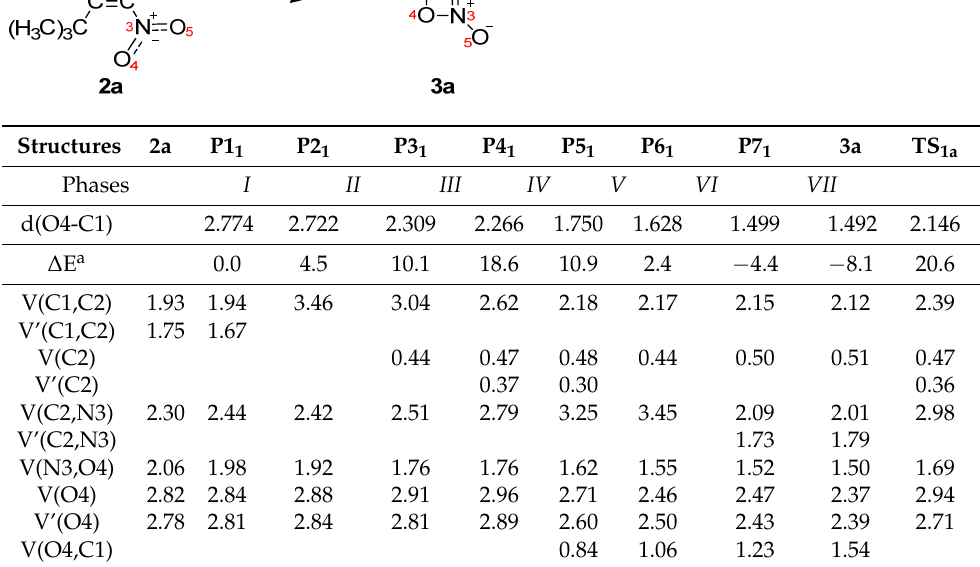
Figure 4. Attractor positions of the most important ELF valence basins of the IRC structures P1 1 – 3a together with simpli- fied representation of the molecular mechanism by Lewis-like structures arising from the topological analysis of the ELF along the reaction path for the formation of 4,4-di-tert-butyl-3-nitromethyl-4H-[1,2]oxazete 2-oxide ( 3a ). Figure shows the most important ELF valence basin populations to illustrate which populations disappear and which form in the individual phase. The electron populations, in average number of electrons, is given in